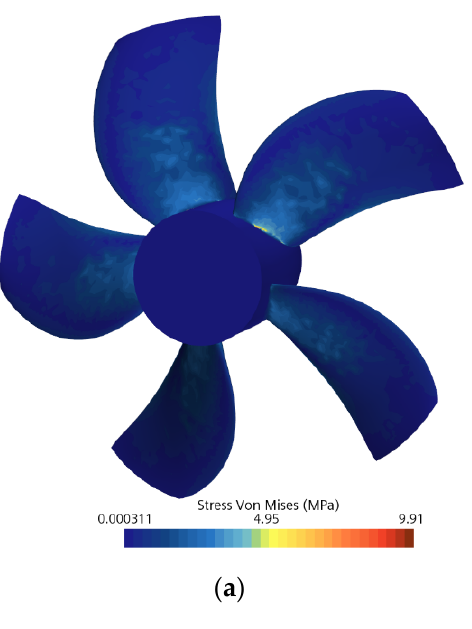
Figure 22. Von Mises stress comparison diagram of pump jet propulsion rotor: ( a ) rotor von Mises stress of parent pump jet propulsion system; ( b ) rotor von Mises stress of optimized pump jet propulsion system.